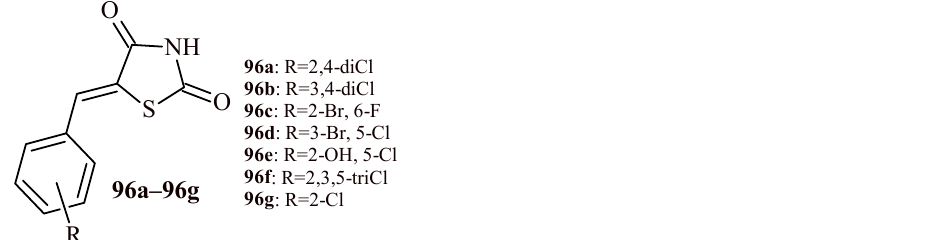
Figure 44. The structure of ethyl 3-[4-oxo-5-[(3-pyridylamino)methylene]-2-thioxothiazolidin-3- yl]propanoate ( 102 ). The good antitrypanosomal activity against T. brucei brucei showed two thiazolidin- 4-one-diclofenac hybrids, namely: [2-(2,6-dichlophenylamino)phenyl]acetic acid N -(3- ethyl-4-oxo-2-thioxothiazolidin-5-ylidenemethyl)hydrazide and [2-(2,6-dichlophenyla- mino)phenyl]acetic acid N -(2,4-dioxothiazolidin-5-ylidenemethyl)hydrazide. Their IC 50 values were 7.06 and 4.8 µM, correspondingly [68]. 2.7. Antimicrobial Activity Despite the wide number of groups of compounds used in microbial and fungal in- fections, diseases continue to grow in strength and their treatment is a serious problem of a medical nature. Widespread and extensive use of antibiotics contributed to the develop- ment of pathogen resistance resulted the need to synthesize new antimicrobial drugs with a mechanism of action bypassing antibiotic resistance. The emergence of multi-resistant pathogenic strains is the undoubted challenge of modern medicine, and the prevention of infectious diseases is a serious global problem [111,112]. S N O O O S NH N